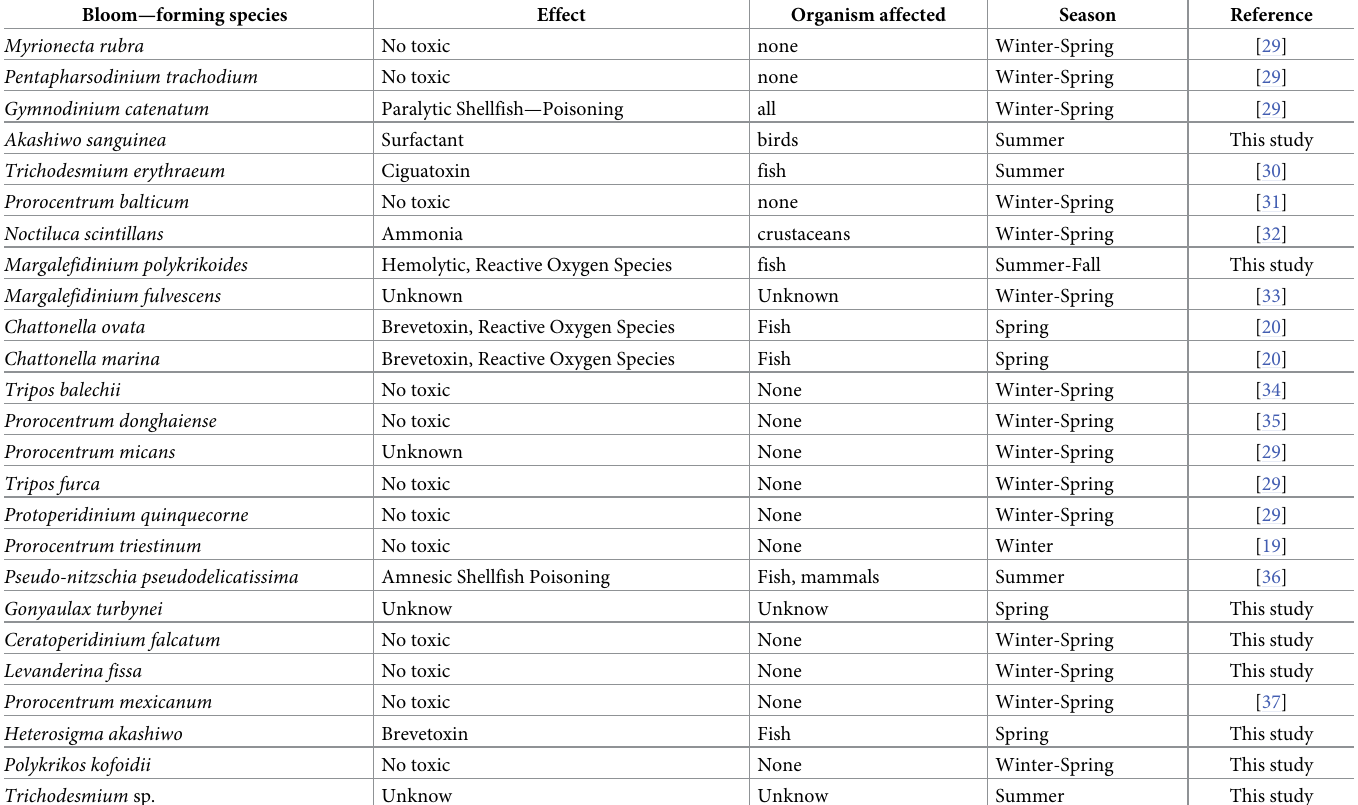
Table 2. Bloom-forming species recorded in Mazatlan Bay, their effects and organism affected. Bloom—forming